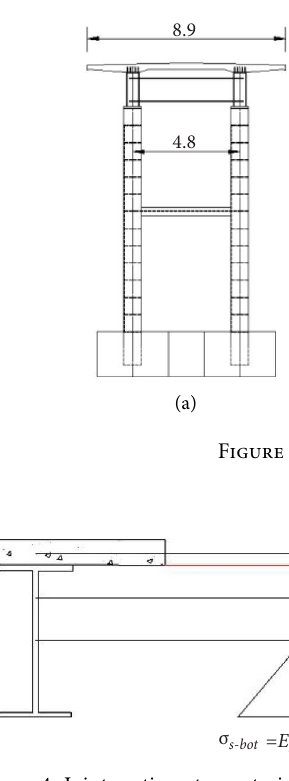
Figure 4: Joint section stress-strain